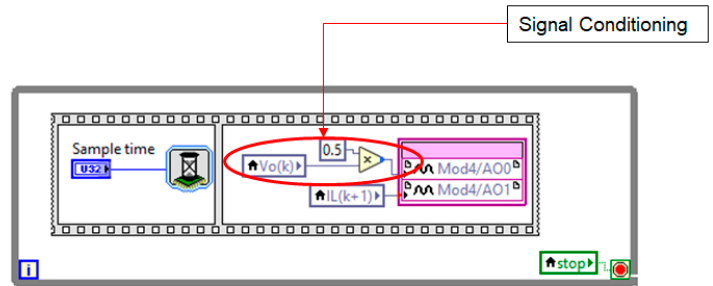
Figure 10. Program used to make the analog representation of v o(k) and i L(k) values at the Digital-Analog Converter (DAC) output available.